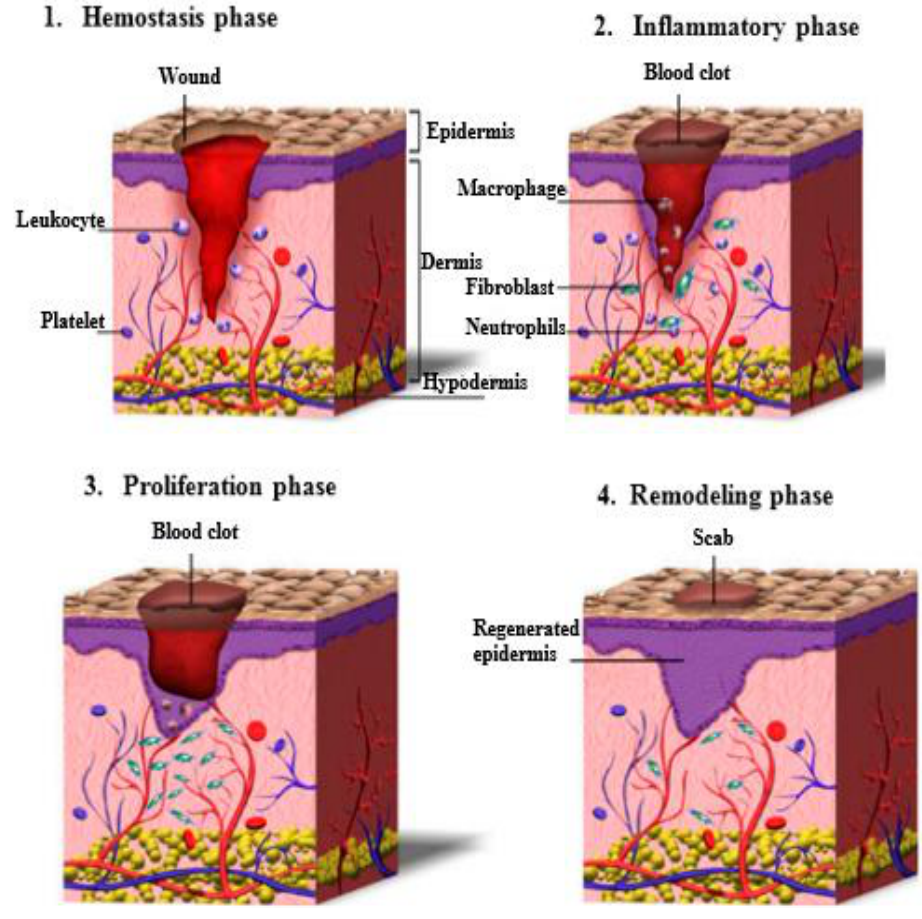
Figure 1. Schematic presentation of the wound healing process. Reproduced from [20], with permis- sion from MDPI, 2022.